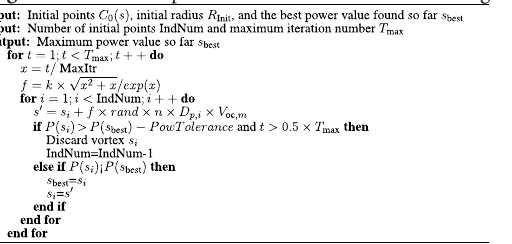
Algorithm 3: Description of the VVS-based GMPPT